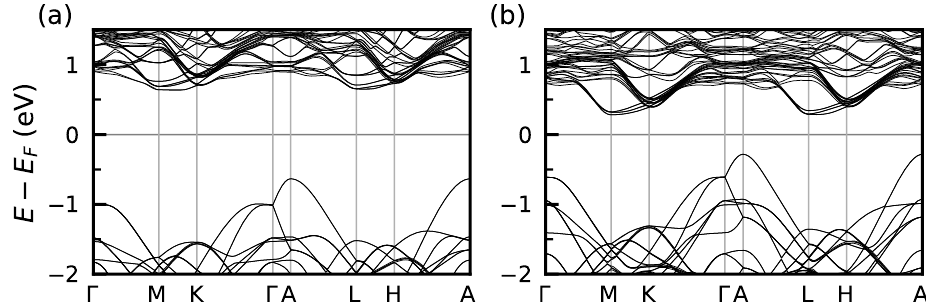
Figure 2. Bulk electronic structure of ( a ) TlGdSe 2 and ( b ) TlGdTe 2 , calculated for the NCAFM spin alignment shown in Figure